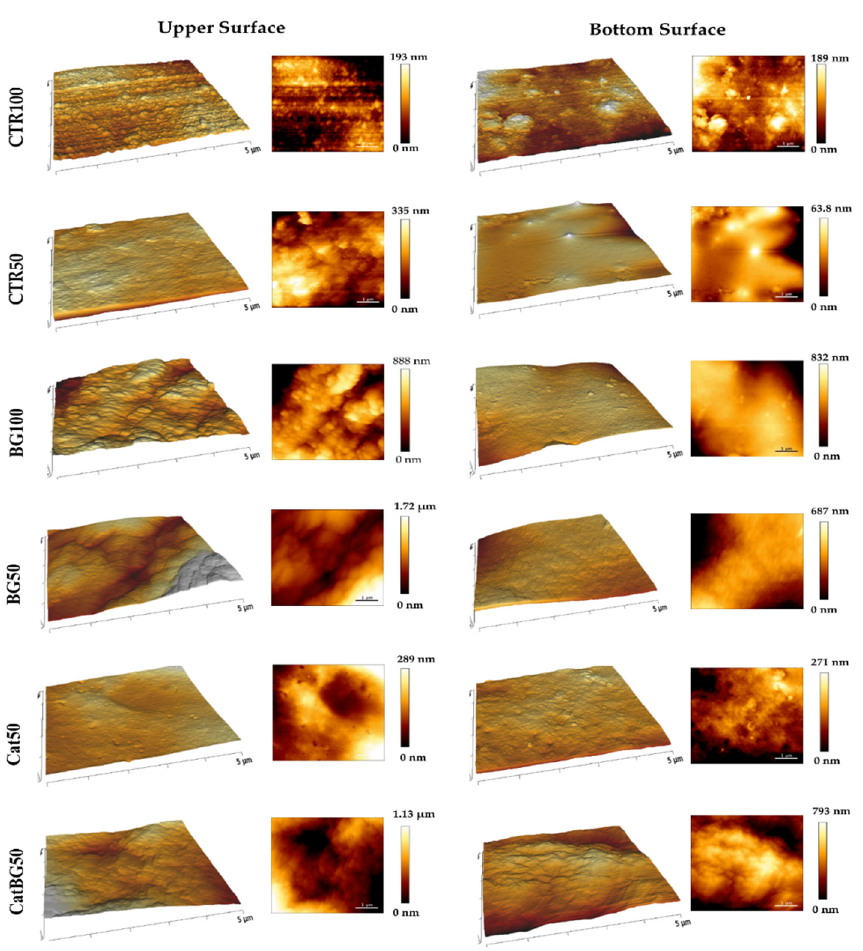
Figure 6. AFM surface images with respective 3D representation of each surface of the LbL films (5 µm × 5 µm).